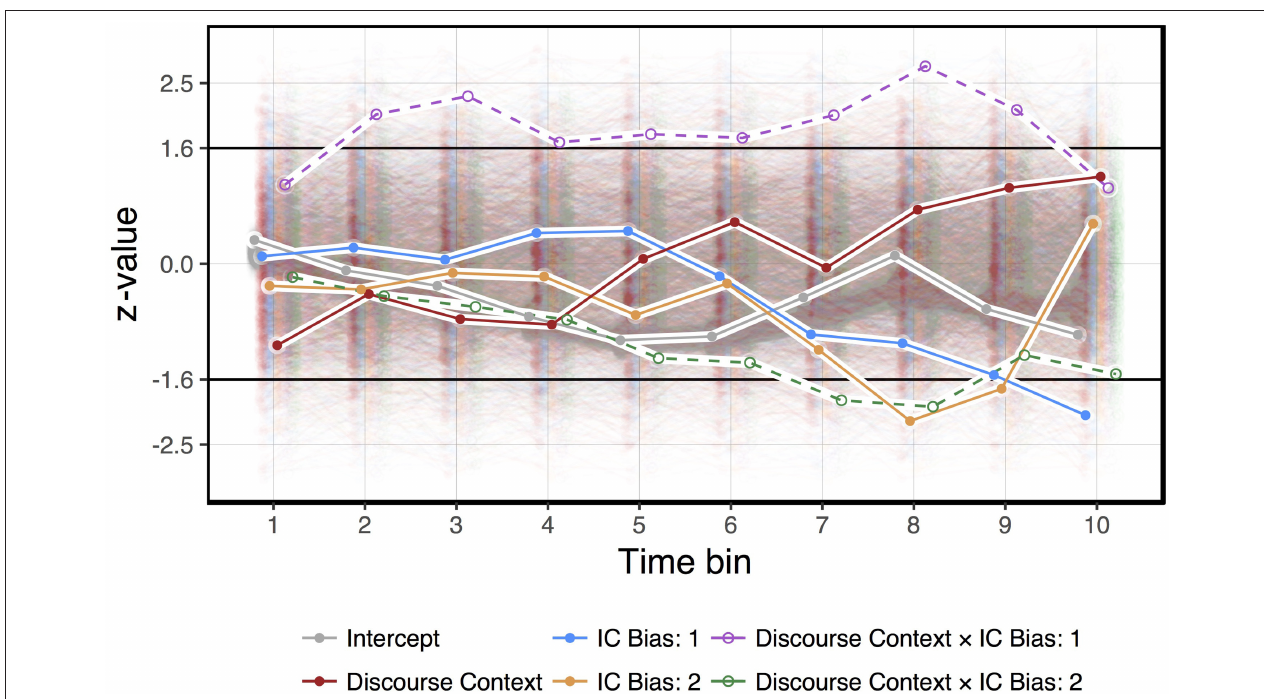
FIGURE 3 | Experiment 1: the z -values for all predictors included in the model across the ten 100ms time bins from the onset of the connective, superimposed onto the empirical distributions of z -values for the permuted predictors in 1,000 simulations.